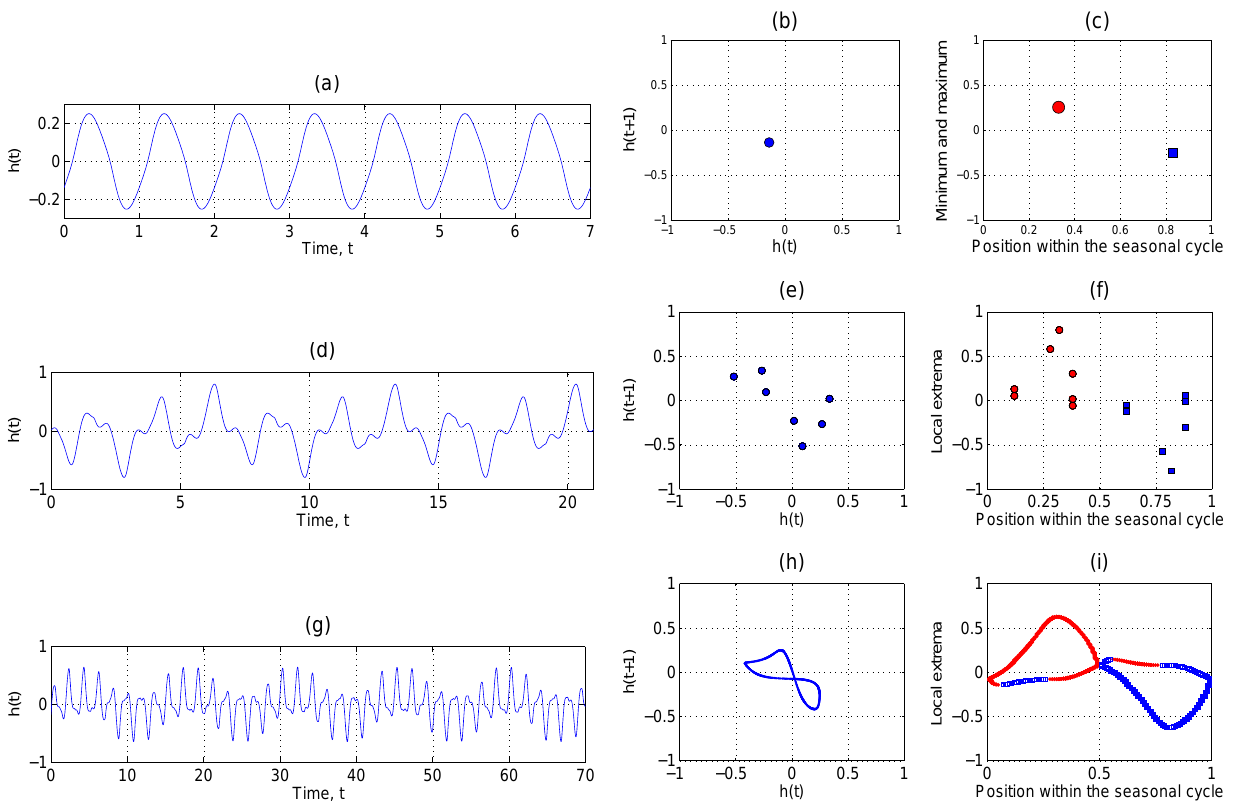
Fig. 4. Seasonal phase locking of local extrema for model trajectories: (a–c) with period P = 1; (d–f) with period P = 7; and (g–i) aperiodic. The model solutions in panels (a, d, g) are shown in the stationary regime, after a sufficiently long transient, and the time axis is shifted so as to start from t = 0. The parameter values for these solutions are (a) τ = 0 . 5, κ = 11, b = 2; (d) τ = 0 . 56, κ = 11, b = 1 . 4; and (g) τ = 0 . 47, κ = 10, b = 1 . 0. The scatterplots of the points (h(t i ),h(t i + 1 )) in panels (b, e, h) use the values i = 0 , 1 ,..., 500, which correspond to t 0 = 2500 and the parameter settings in panels (a, d, g), respectively. The phase locking is illustrated in panels (c, f, i), which give the h -value of the local extrema – maxima shown as red filled circles and minima as blue squares – as a function of their position within the seasonal cycle, ϕ = t( mod 1 )